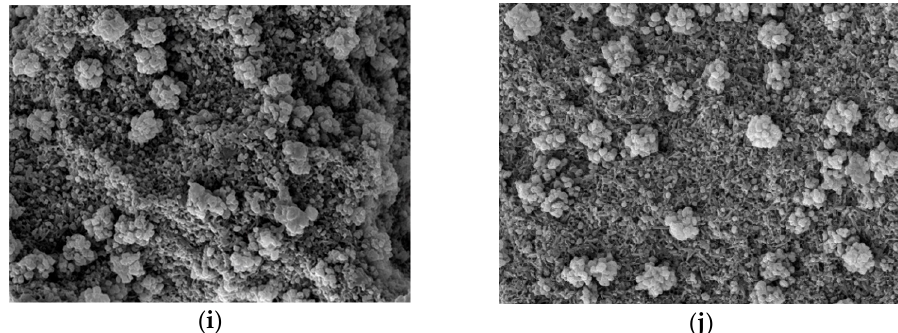
Figure 2. SEM pictures of the materials tested in both LT and HT formulations (20.000×). ( a ) Empress CAD LT; ( b ) Empress CAD HT; ( c ) e.max CAD LT; ( d ) e.max CAD HT; ( e ) Celtra Duo LT; ( f ) Celtra Duo HT; ( g ) n!ce LT; ( h ) n!ce HT; ( i ) LiSi Block LT; and ( j ) LiSI Block HT.